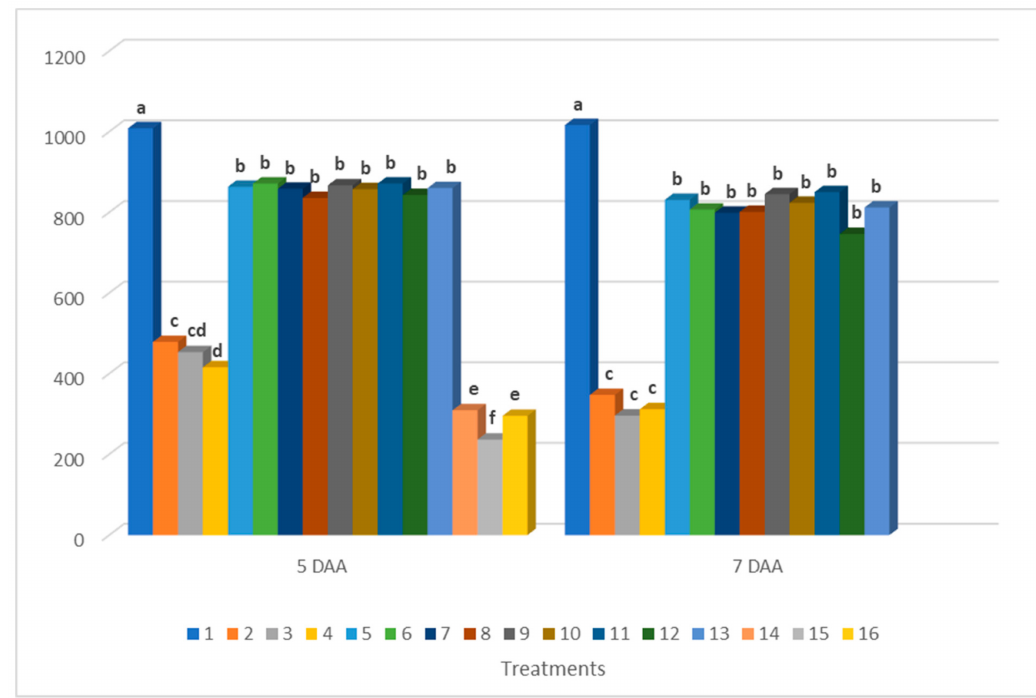
Figure 2. The effect of herbicides on Fm—maximum fluorescence of dark-adapted state (non-nominated units). a–f different letters indicate statistically different mean LSD ( p < 0.05) 5 DAA = 48.86; LSD ( p < 0.05) 7 DAA = 67.27. (1—untreated; 2–16 herbicides applied at different pH of the spray solution: 2–4—mesotrione; 5–7—nicosulfuron; 8–10—rimsulfuron; 11–13—mesotrione + nicosulfuron + rimsulfuron + adjuvant; 14–16 bromoxynil; details description of treatments is included in Table 1).